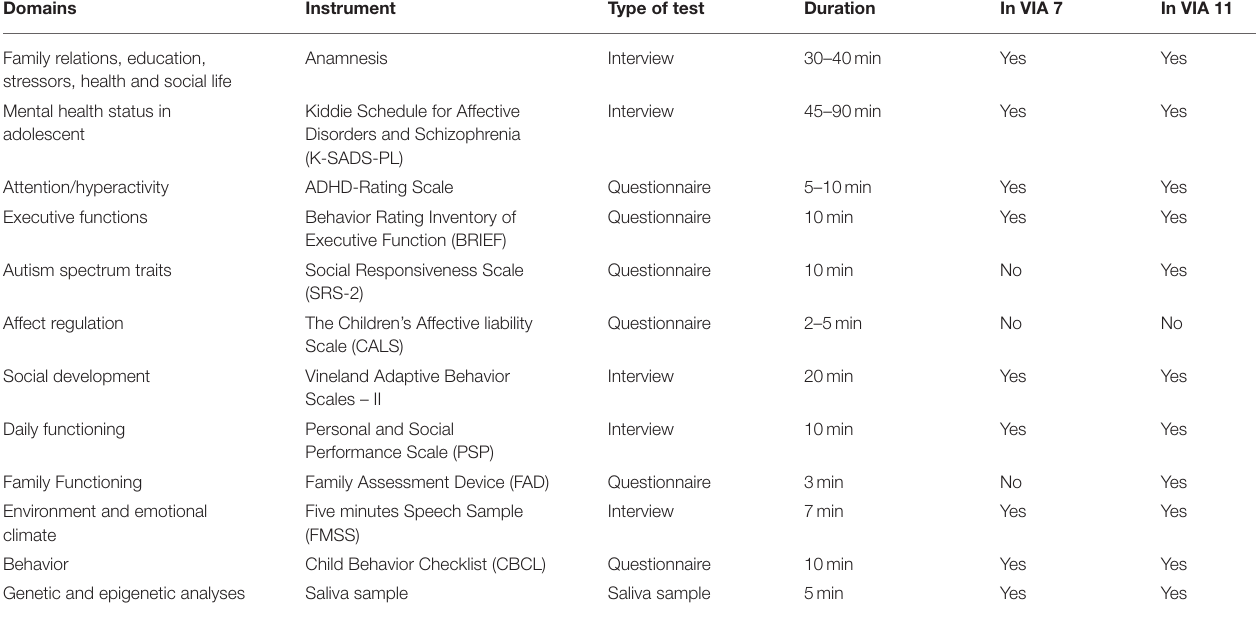
TABLE 2 | Assessment battery for the primary caregiver in The Danish High Risk and Resilience Study—VIA 15.